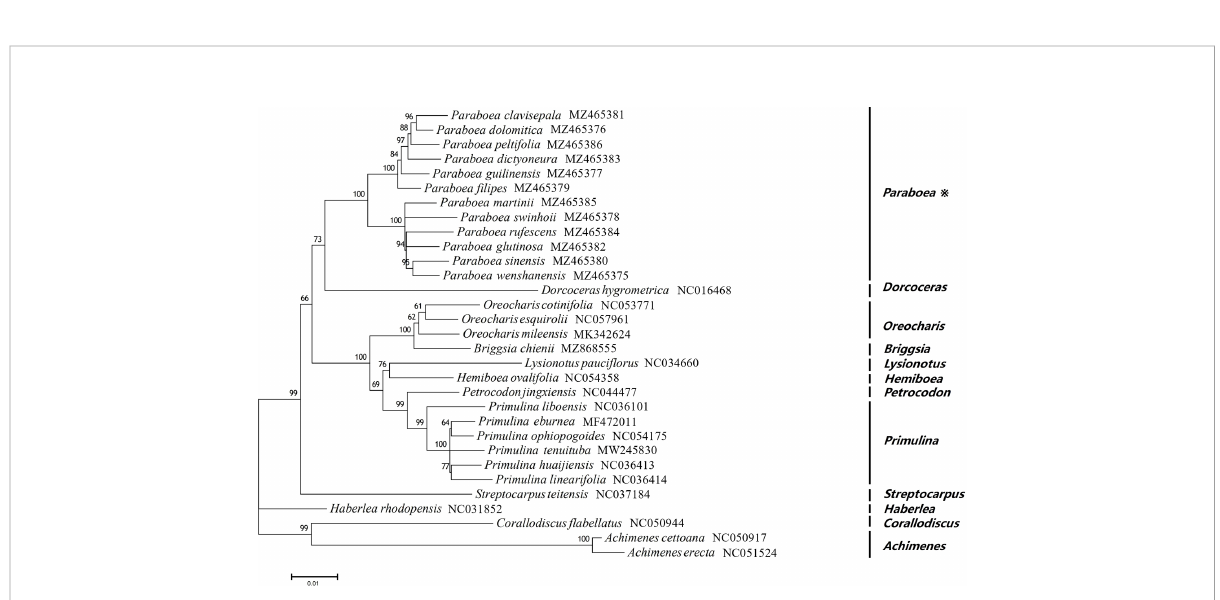
FIGURE 6 The ML phylogenetic tree of 31 Gesneriaceae species. Supporting values of > 50% for ML were shown on the